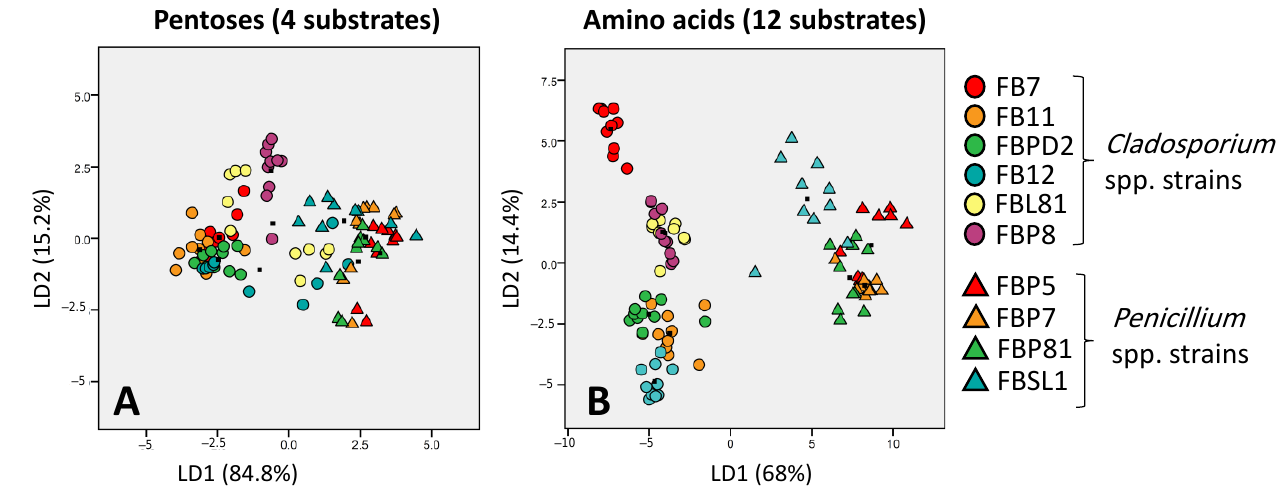
Figure 5. Discriminative ability of pentoses (the worst discriminator) ( A ) and amino acids (the best discriminator) ( B ) in separating six and four Cladosporium spp. and Penicillium spp. strains, respectively; based on Atanasove and Druzhinia [40] categorization. LD1 and LD2 show that many percentages of variance observed in the dataset are explained using linear dimension 1 and linear dimension 2.